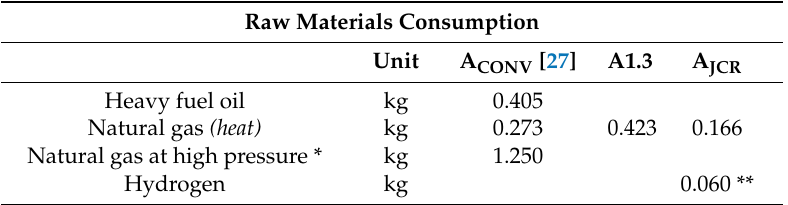
Table 4. Consumption of raw materials (per unit of kg of